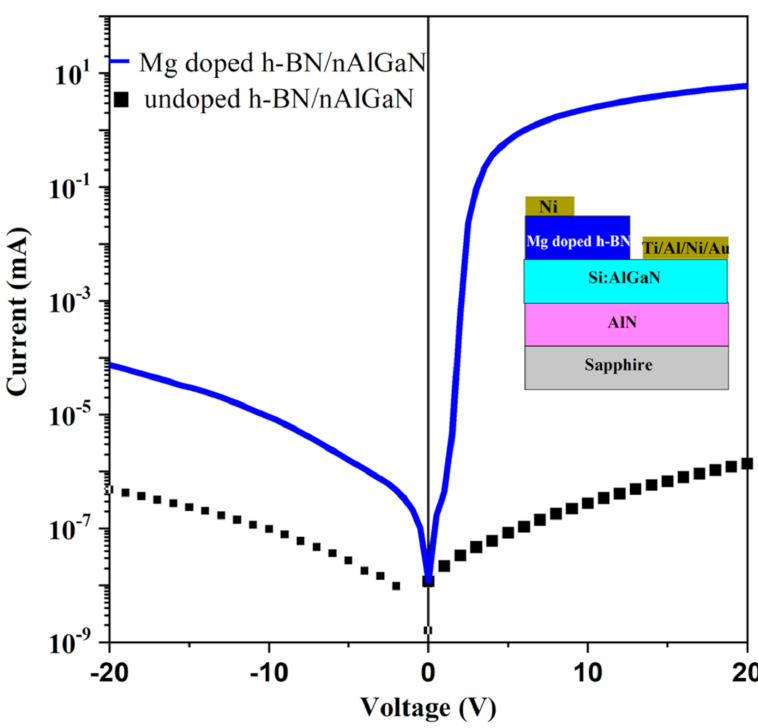
Figure 6. Current–voltage characteristics of undoped and Mg doped BN/n-Al 0.58 Ga 0.42 N (Samples E and F) devices measured at room temperature. Nanomaterials 2021 , 11 , x FOR PEER REVIEW 9 of 13